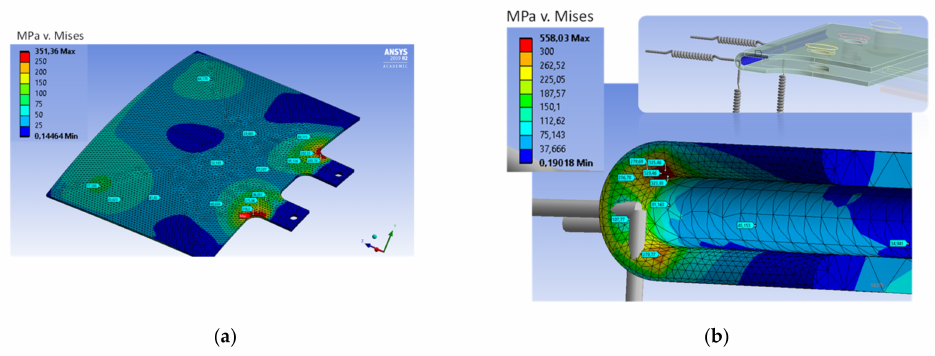
Figure 11. Results FE simulation: ( a ) blade material: EN AW-7075-T6, t = 2.0 mm; ( b ) blade material: EN AW-7075-T6, t = 2.0 mm, U-shaped sheet: DP600, t = 1.0 mm.